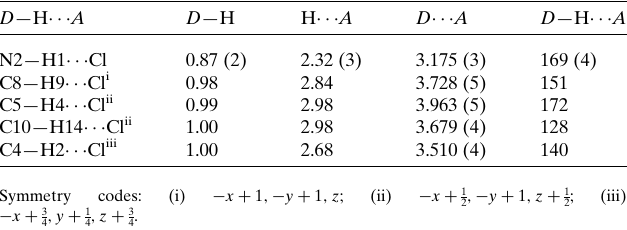
Table 2 Hydrogen-bond geometry (A˚ , (cid:5) ) for 4 .